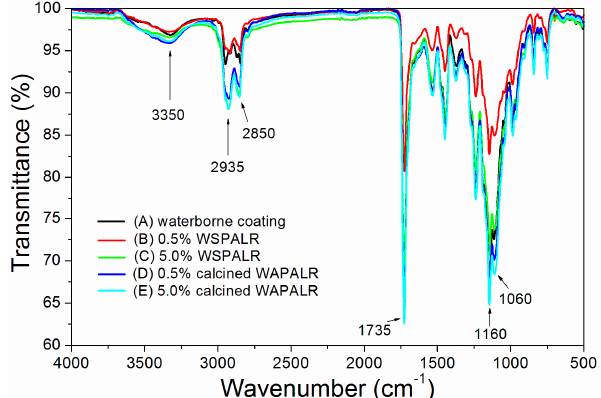
Figure 5. The infrared spectrum: ( A ) waterborne coating; waterborne coating with different concentrations of WSPALR: ( B ) 0.5% and ( C ) 5.0%; and waterborne coating with different concentrations of calcined WSPALR: ( D ) 0.5% and ( E ) 5.0%.